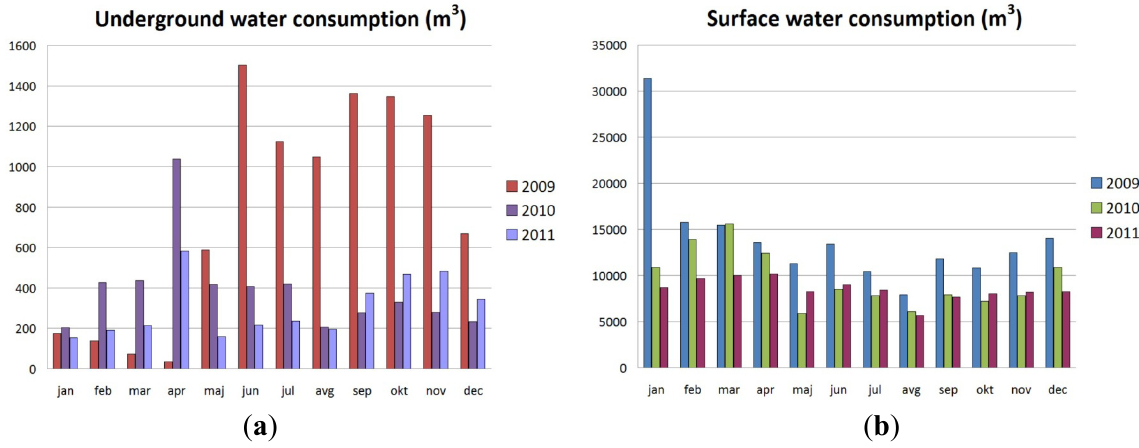
Figure 11. Water consumption in years 2009 to 2011: ( a ) in underground mining processes; ( b ) on surface